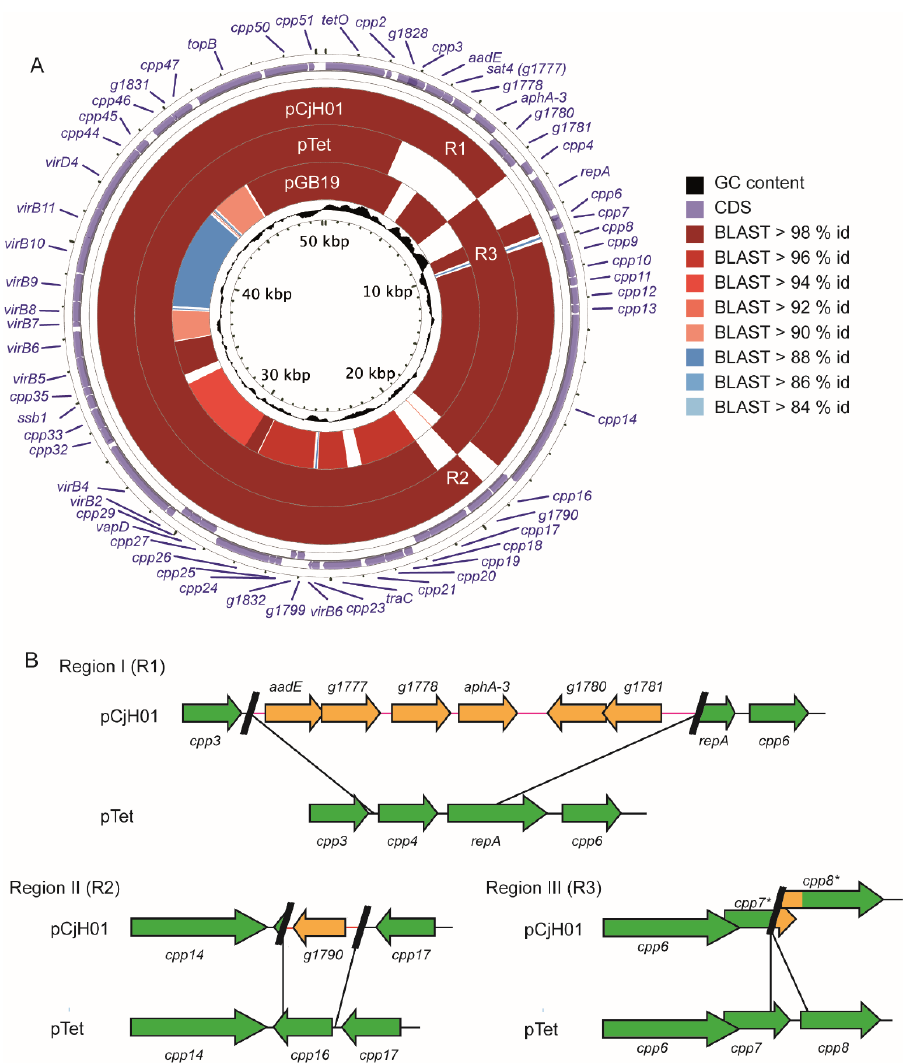
Figure 3. The pCjH01 plasmid has high similarity with the pTet plasmid. ( A ) Comparison between the pCjH01, pTet, and pGB19 plasmids. The regions I (RI), II (RII), and III (RIII) are indicated. The three plasmids were aligned by blastn to an inclusive artificial “pangenome” sequence constructed from both pCjH01 and pTet to show regions that are present or absent from each plasmid with respect to the others. The level of BLAST percent identity is indicated by color according to the legend. The annotated ORFs correspond to the combined annotation of all three plasmids. ( B ) Representation of regions I, II, and III in both pCjH01 and pTet. Green arrows and black lines indicate the sequences present in both plasmids, whereas orange arrows and red lines indicate the sequences only present in pCjH01.